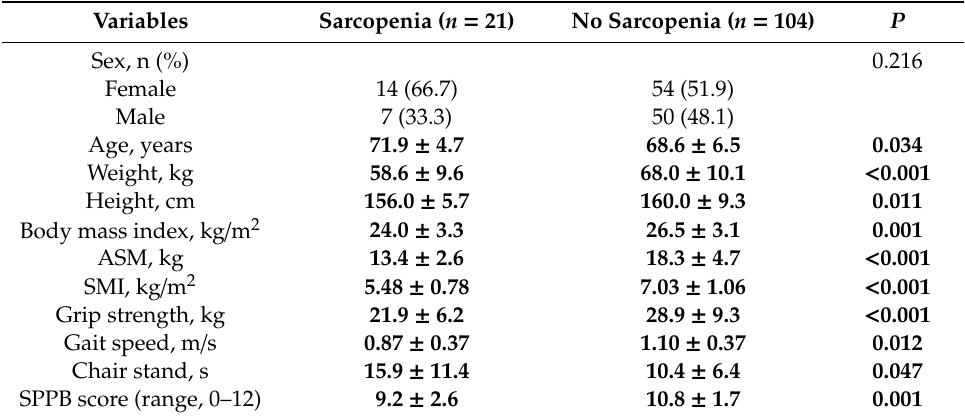
Table 1. Baseline characteristics of the study population according to sarcopenia status.